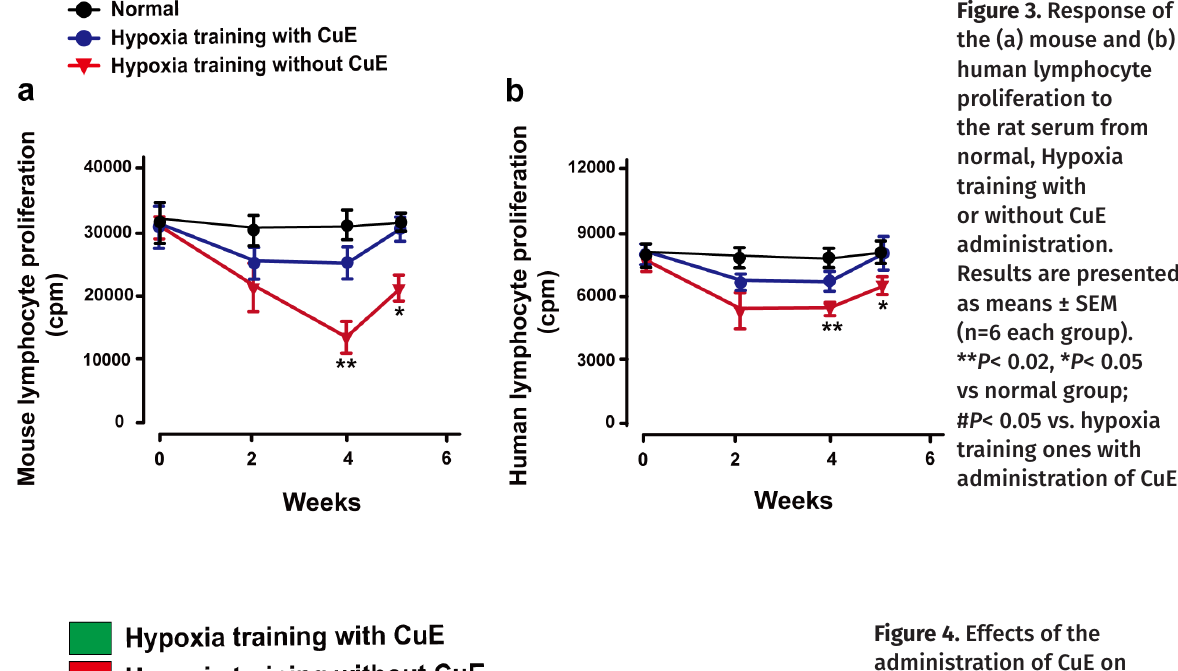
Figure 4. Effects of